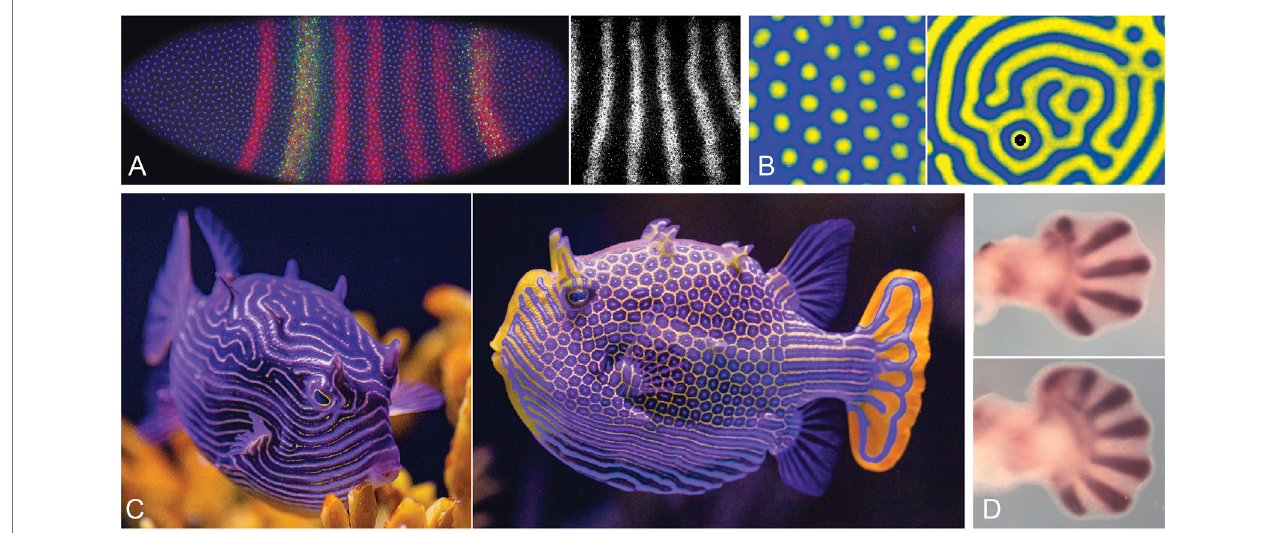
FIGURE 2 | Selected animal and chemical patterns: stripes, spots, and digits. (A) . The Drosophila pair-rule pattern. Left: an embryo at stage 5 (length 505 μ m, anterior to the left), nearing the completion of cellularization; nuclei in blue, even-skipped ( eve ) protein in red, with an enhancer tag (green) showing speci fi city for some stripes rather than others, aclear demonstration ofstripe-speci fi ccontrolover eve expression.Right: detailofthe ev etranscript pattern; stripespacing(centre-to-centre distance)isca.40 μ m. (B) .Chemicalpatterns, showingarraysofspots(left)andlabyrinthinestripes(right)produced bytheTuIS(thiourea-iodate-sul fi te)reaction in a gel medium, a variant of the better known CIMA reaction. Spacing between pattern elements is ca.2 mm; seeHorvath et al.(2009) for details. (C) . The ornate box fi sh, Aracanaornata ,nativetowatersoff South Australia; female (left)and male(right) showing mixed stripe and spotted patterns characteristic ofbox fi shes, which often vary betweenthesexesdespite,presumably,acommonunderlyingmechanism. (D) .Digitdevelopmentinmouseembryos,showingpatternsofthemarker Sox9 inwildtype limb(top)andtheexpandedfanofdigitsproducedbythehomozygous Gli3 nullmutant(bottom).Thepatternhereisrealizedasaseriesofcartilaginouselements,butisa result of a one-dimensional periodicity along the limb margin that lays down a two-dimensional pattern as the limb grows (Hiscock et al., 2017), a 1D to 2D transition comparable to that seen in Micrasterias . The number of digits increases further in Hox11/13 mutants, but the underlying pattern results from Turing-type interactions betweentheproteinproductsof Bmp , Sox9 and Wnt genes;seeRaspopovicetal.(2014)fordetails;Onimaruetal.(2016),Stewartetal.(2017),Newmanetal.(2018)for evolutionary perspectives. Photo credits: (A, left) Thomas Gregor, (A, right) Erik Clark, (B) Istvan Szalai, (C) the Birch Aquarium at Scripps, (D) Rushikesh Sheth and Marian